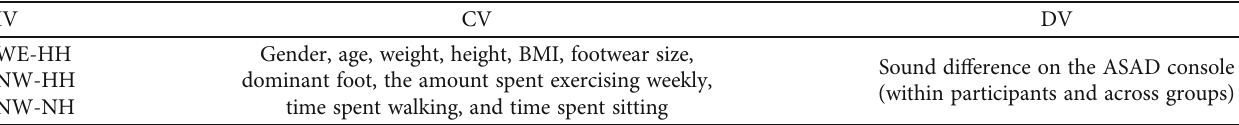
Table 1: Variables in the study. IV = independent variables; CV = covariable; DV = dependent variable. IV CV DV WE-HH Gender, age, weight, height, BMI, footwear size, (within participants and across